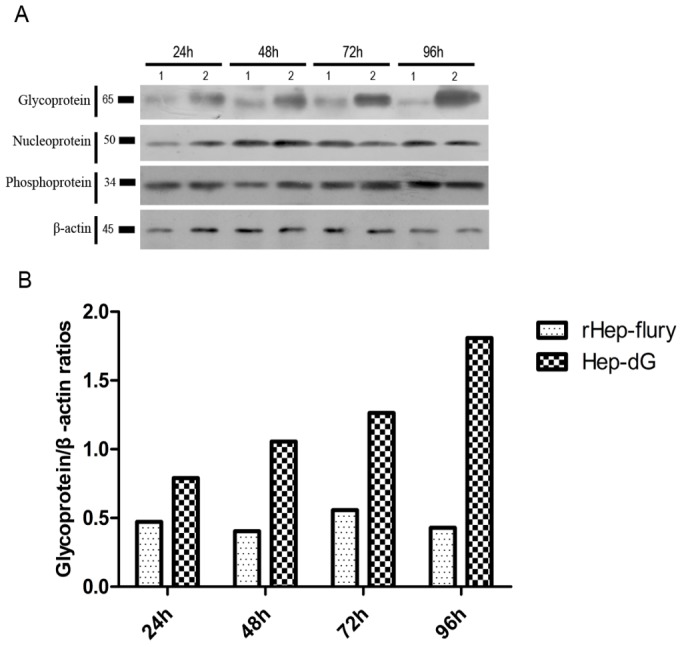
Western blot analysis of RV proteins.BHK-21 cells were infected with HEP-dG and rHEP-Flury at an MOI of 1. After incubation for 24, 48, 72, 96 h at 37°C, the cells were lysed and proteins separated by SDS-PAGE. The G, N and P proteins of HEP-dG(lane 2) and rHEP-Flury(lane 1) and β-actin were detected by mouse anti-rabies virus G, N and P monoclonal antibody and β-actin mAB reagent (A). The relative amounts of G protein were determined by a molecular imager(B).